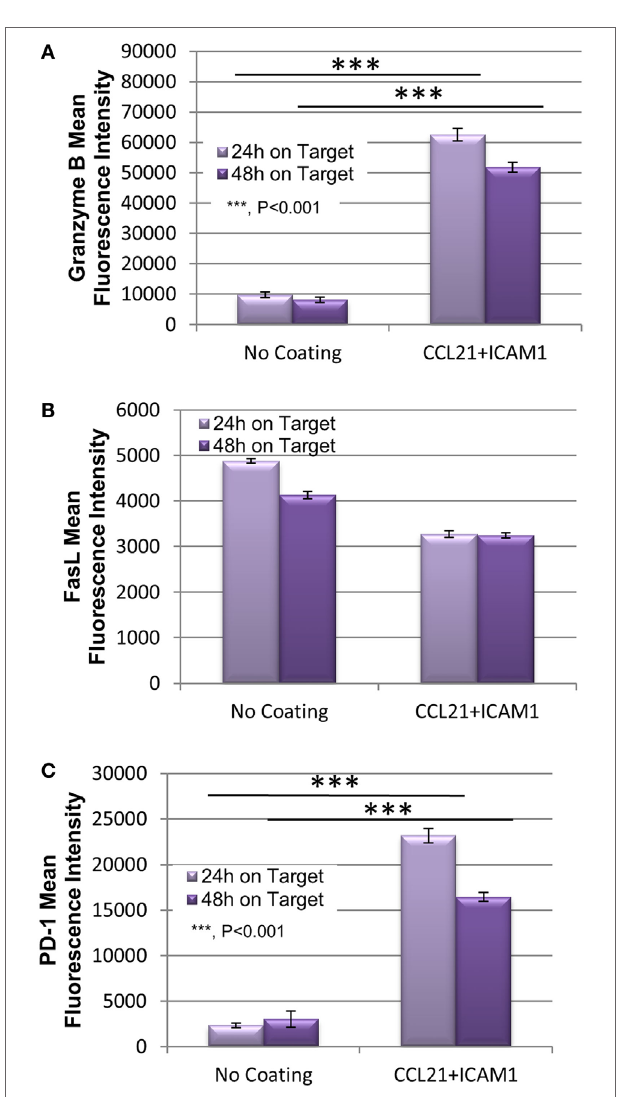
FigUre 6 | Substrate-immobilized CCL21 + ICAM1 increase T-cell expression of Granzyme B and PD-1, while not affecting FasL. (a–c) Bar graph illustrating the mean fluorescence intensity of granzyme B (a) , FasL (B) , and PD-1 (c) in cytotoxic T-cells following their incubation for 24 and 48 h with B16-ovalbumin target cells. T-cells were pre-cultured for 7 days on either an uncoated substrate, or on substrate-immobilized CCL21 + ICAM1 [data are from one experiment representative of three independent experiments with four replicates each (see Figure S4 in Supplementary Material). Error bars represent SEM. Calculated p -values (using standard t -test) are as indicated in the Figure].